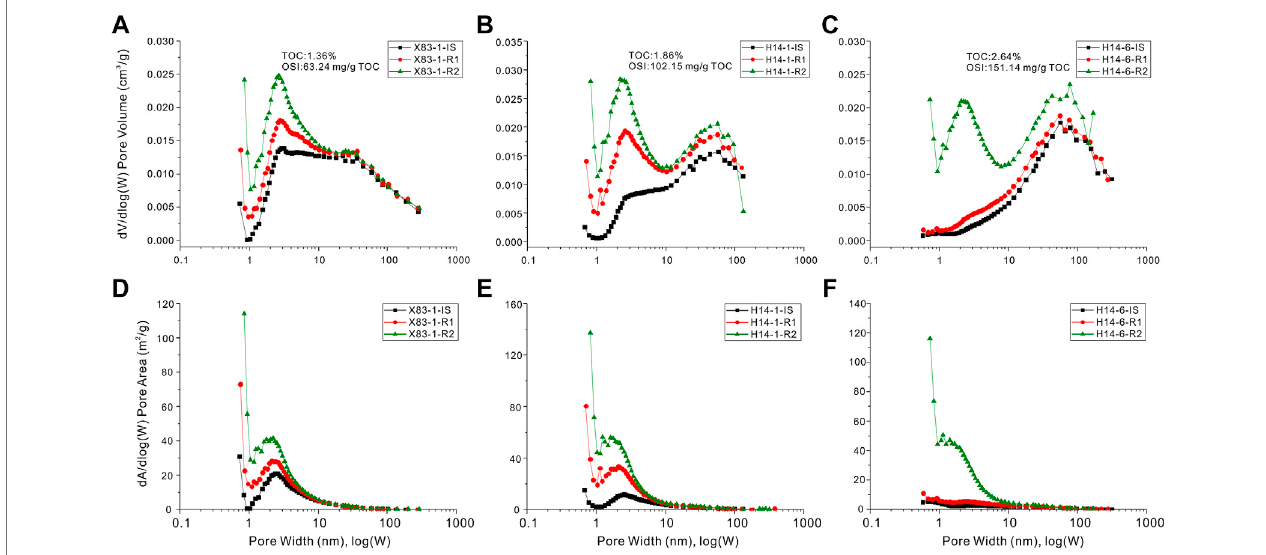
FIGURE 10 | Plot showing correlation of pore sizes and special surface area distributions with pore width from N 2 adsorption isotherm using BJH model.